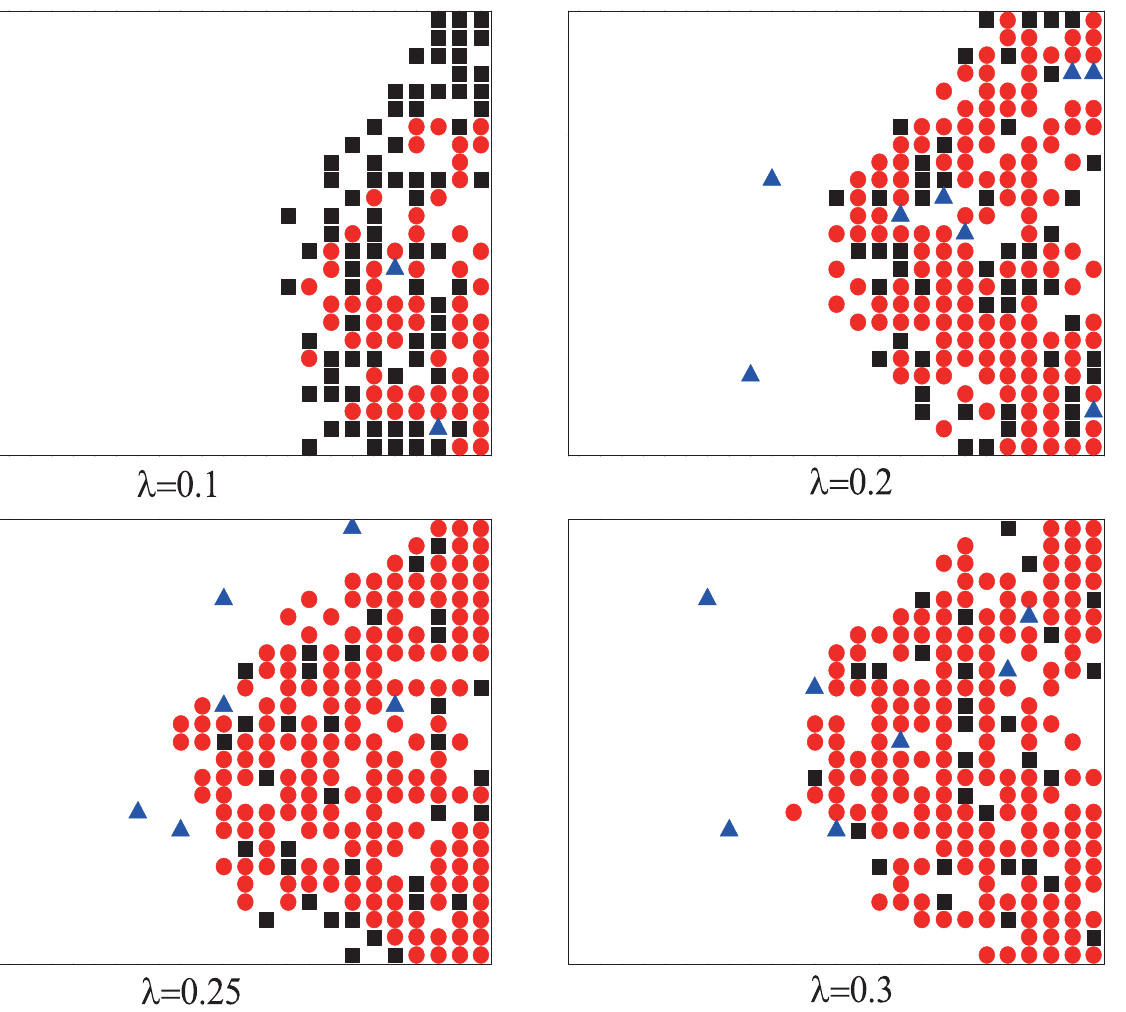
Fig 9. Typical pattern of distribution of pedestrians on the squarelattice 25 × 25 for different λ when t = 300. The pedestrians with motion mode I are indicated by black squares, the pedestrians with motion mode II are indicated by red circles, and the wounded people are indicated by blue triangles. Initially, N II =